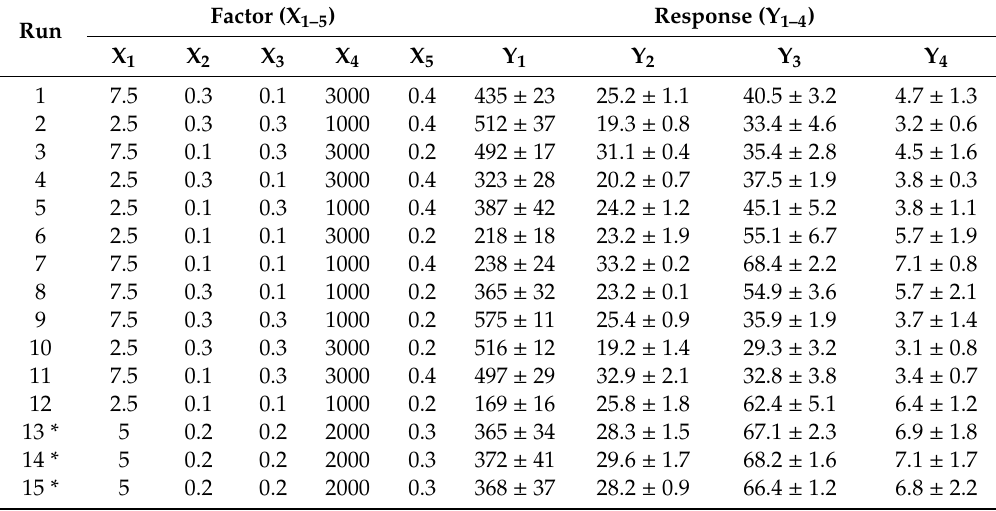
Table 2. Factors and observed responses in the